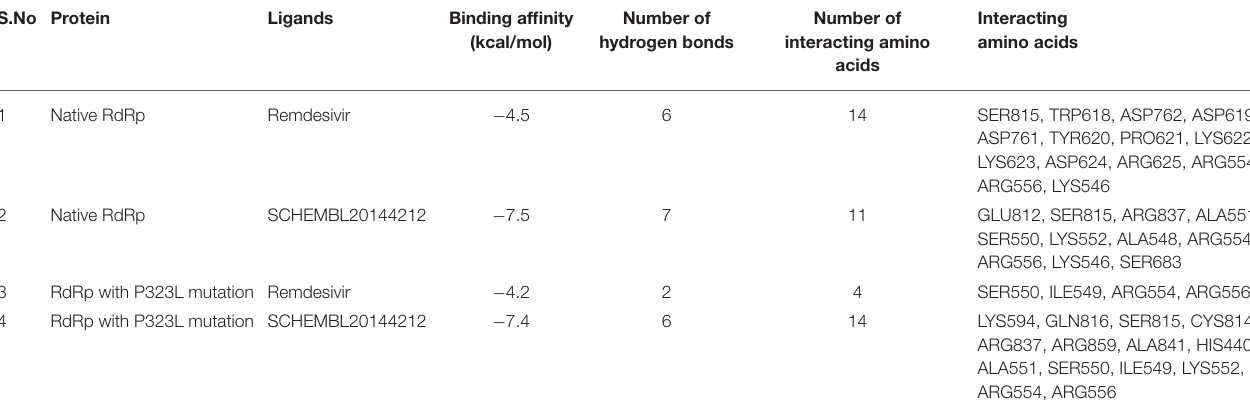
TABLE 3 | Differences in the binding affinity (kcal/mol), number of hydrogen bonds, number of interacting amino acids, and Interacting amino acids between native and mutant RdRp against Remdesivir and the novel lead compound. S.No Protein Ligands Binding affinity